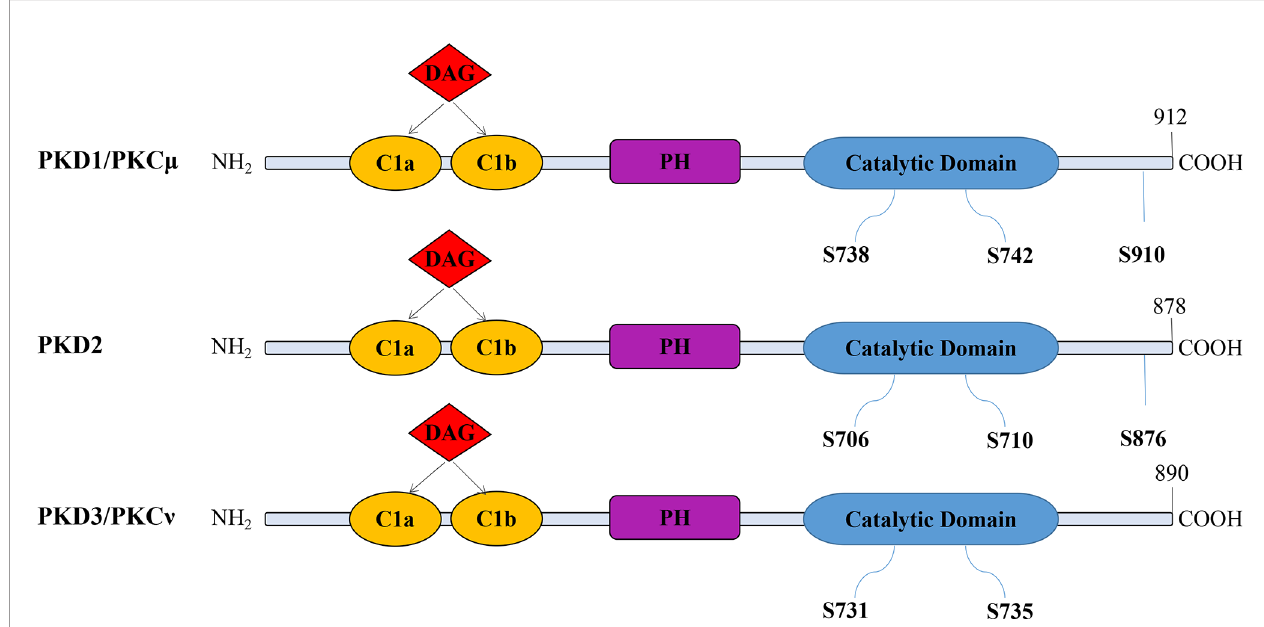
FIGURE 1 | The modular structure of PKD isoforms. The PKD isoforms have highly homologous structures containing cysteine-rich Zn- fi nger-like motifs (CIa and CIb), a pleckstrin homology (PH) domain, and a C-terminal catalytic domain. PKDs are activated by the phosphorylation of serine residues. However, PKD3 lacks a C-terminal autophosphorylation site within the PDZ (PSD-95/Discs large/ZO-1) binding motif present in both PKD1 and PKD2 (S910 in PKD1; S876 in